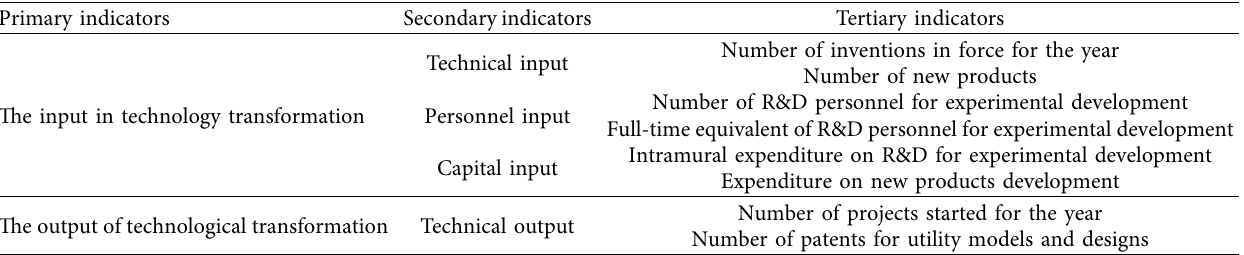
Table 2: Indicator system of technology transformation stage.